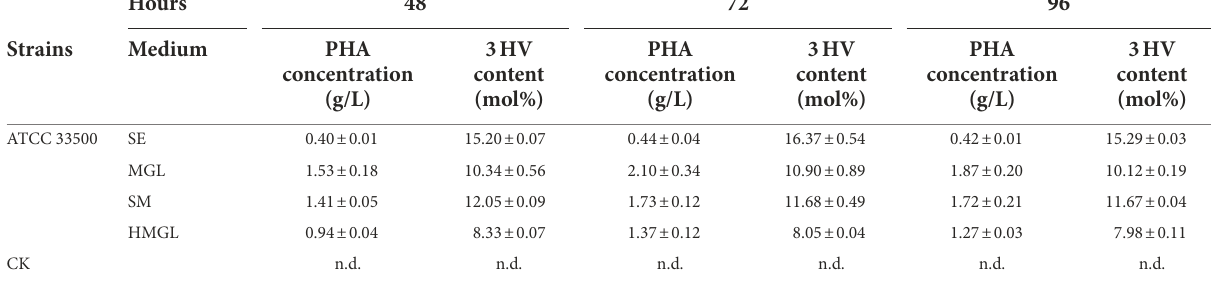
TABLE 4 The PHA accumulation in open fermentation.